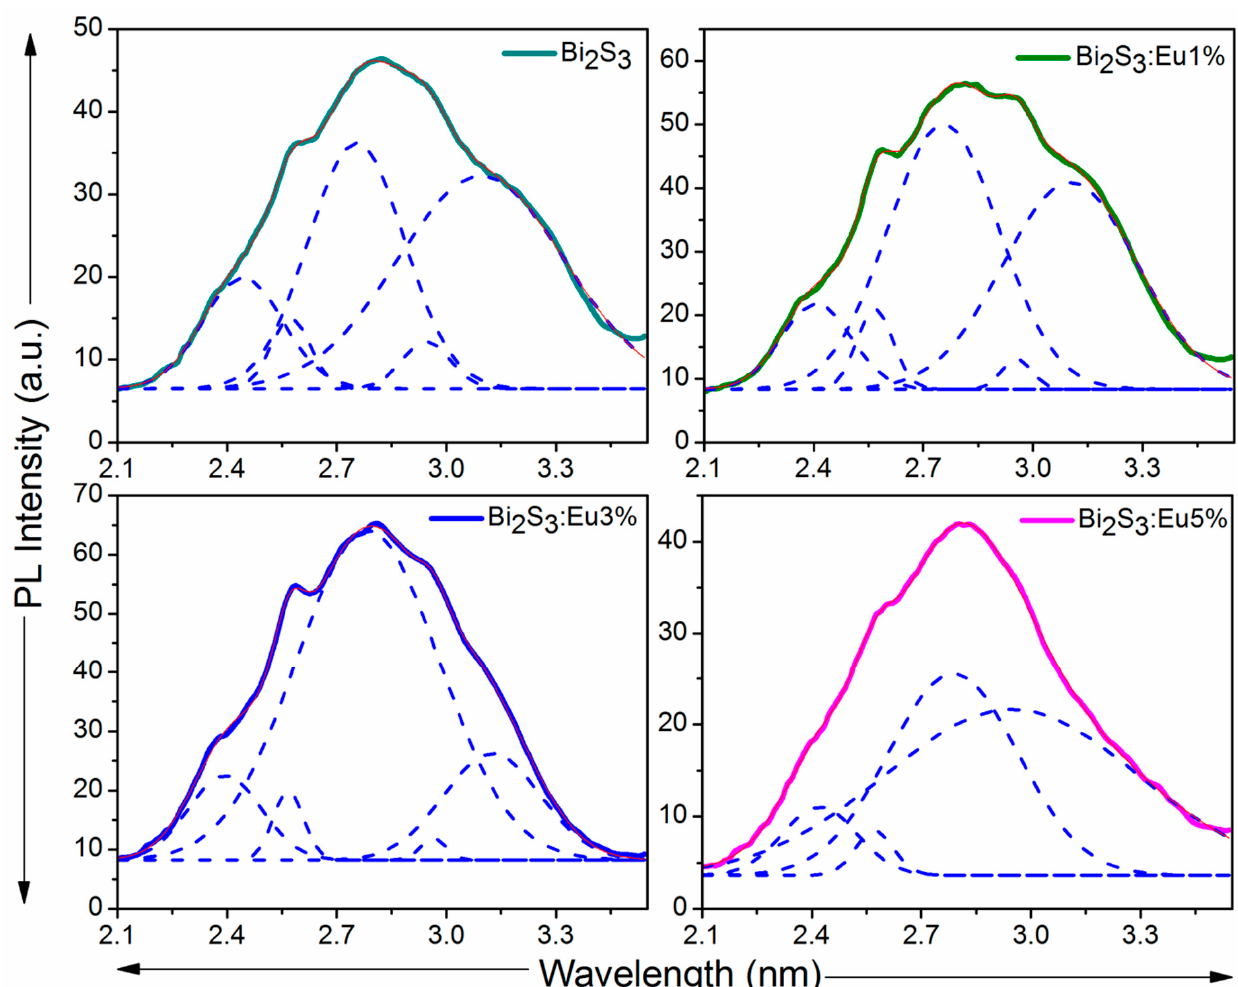
Figure 4. Photoluminescence spectra of Eu-doped Bi 2 S 3 thin films with different Eu concentrations.